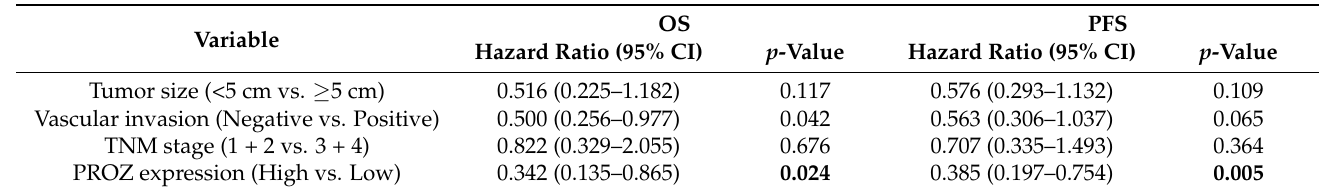
Table 2. Multivariate Cox proportional hazards analysis in the overall patients.